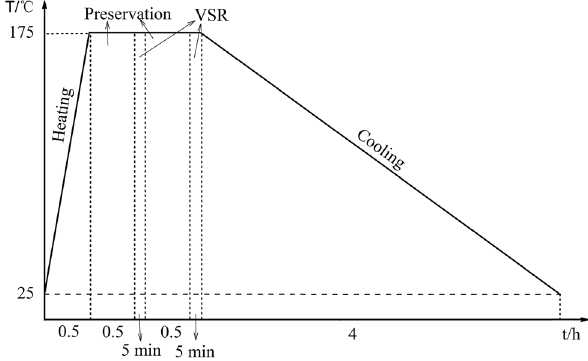
Figure 8: FEM boundary conditions for equivalent sti ff ness